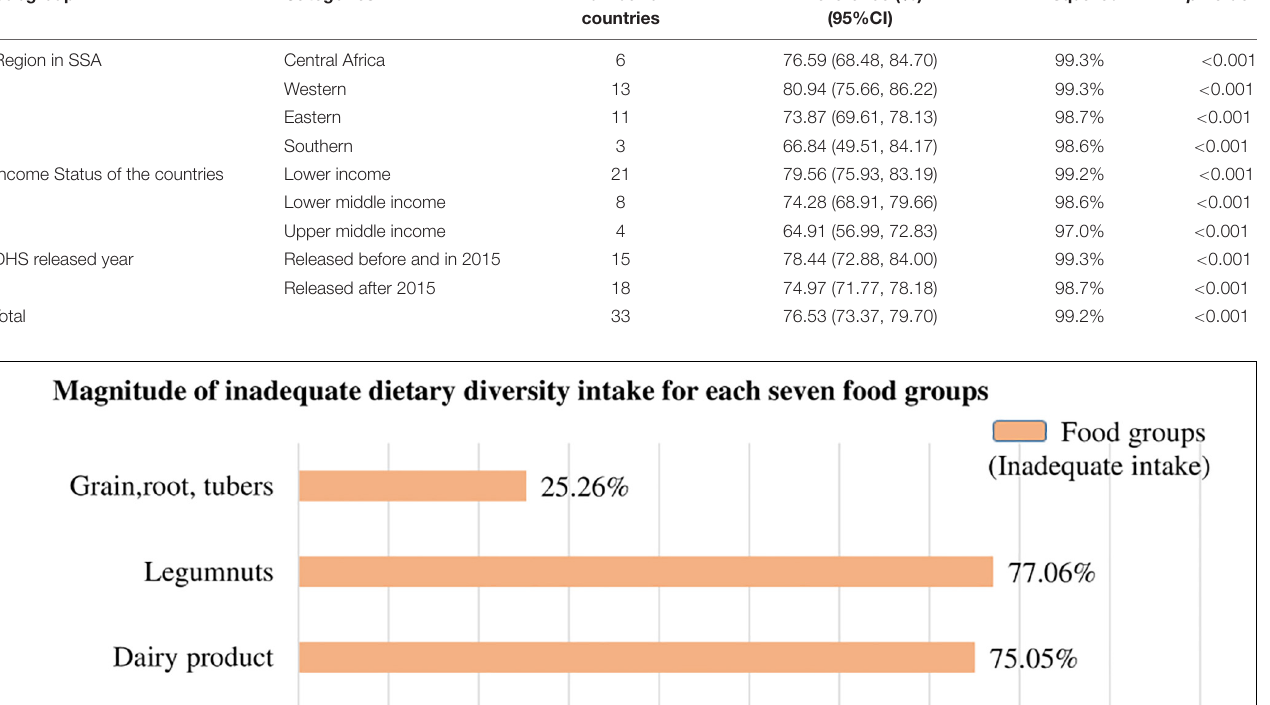
TABLE 5 | Subgroup analyses of inadequate minimum dietary diversity intake among children in SSA. Subgroup